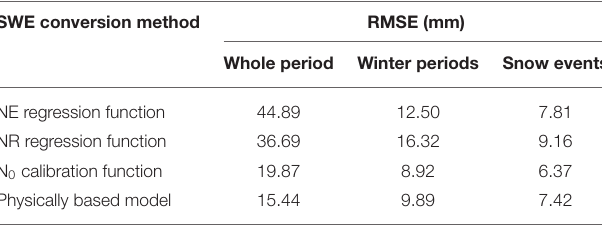
TABLE 1 | RMSE calculated between snow depth-derived and CRNP-derived SWE for different periods indicating the quality of CRNP-based SWE estimation using different conversion